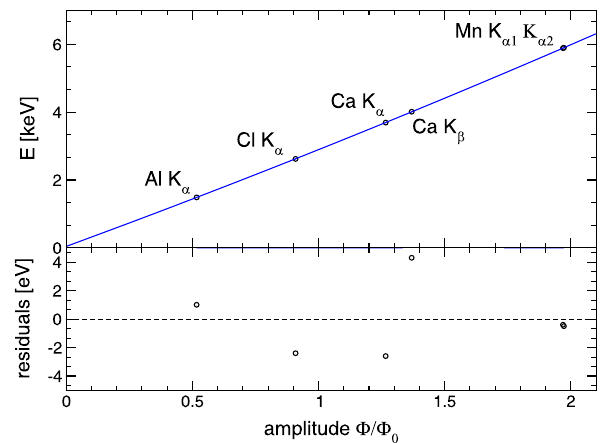
Fig. 4 The empirical second order calibration curve used to convert the output units of the SQUID ( φ 0 ) into energy units for the detector a : + 2 . 7345 φ + 0 . 041166.Theerrorsarecompatible E[keV]=0 . 11927 φ 2 0 0 with the dimensions of the points. It is possible to appreciate how the wide energy range considered for the calibration introduces an non-